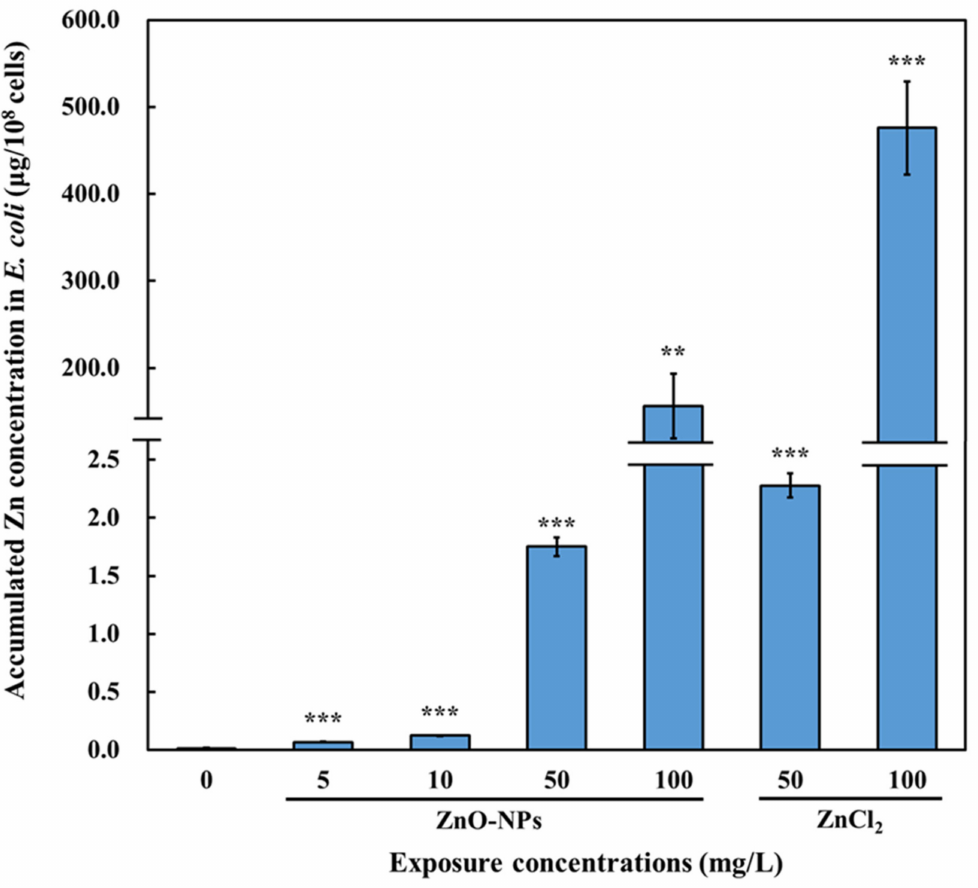
Figure 2. Accumulated Zn concentration in E. coli OP50 upon ZnO-NP or ZnCl 2 exposure. Saturated E. coli OP50 were diluted and incubated in LB medium with various concentrations of ZnO-NPs or ZnCl 2 for 8 h at 37 ◦ C. Subsequently, E. coli OP50 pellet was washed and collected for Zn concentra- tion analysis using ICP-AES. The data are shown as the mean ± SEM. Statistical significance was determined by ANOVA with LSD post-hoc test to compare to the control (0 mg/L). (**: p < 0.01, ***: p <